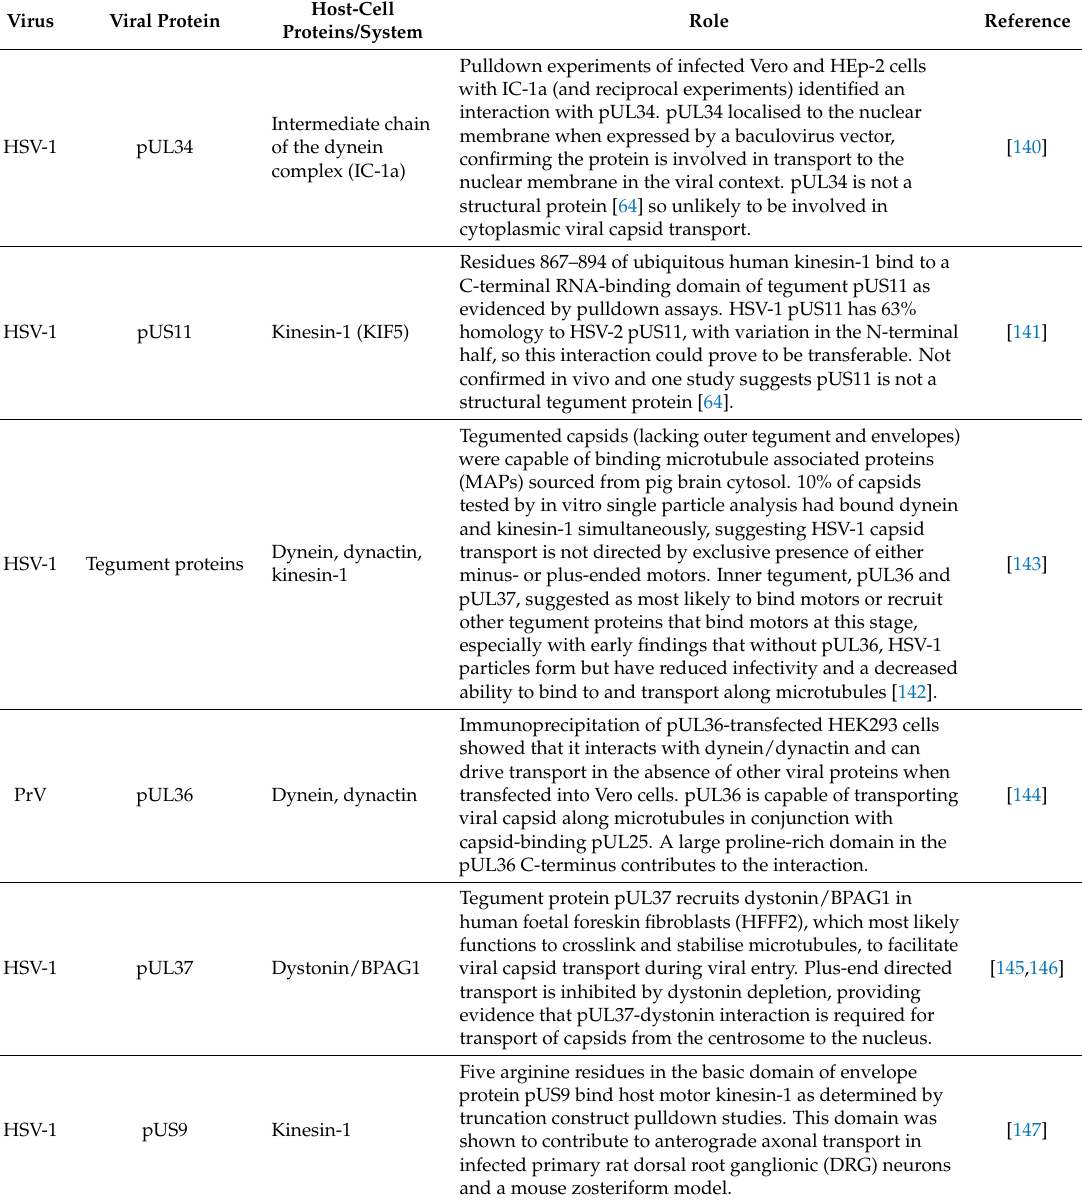
Table 4. Alphaherpesvirus-host interactions that exploit microtubule-based motors dynein and kinesin. Virus Viral